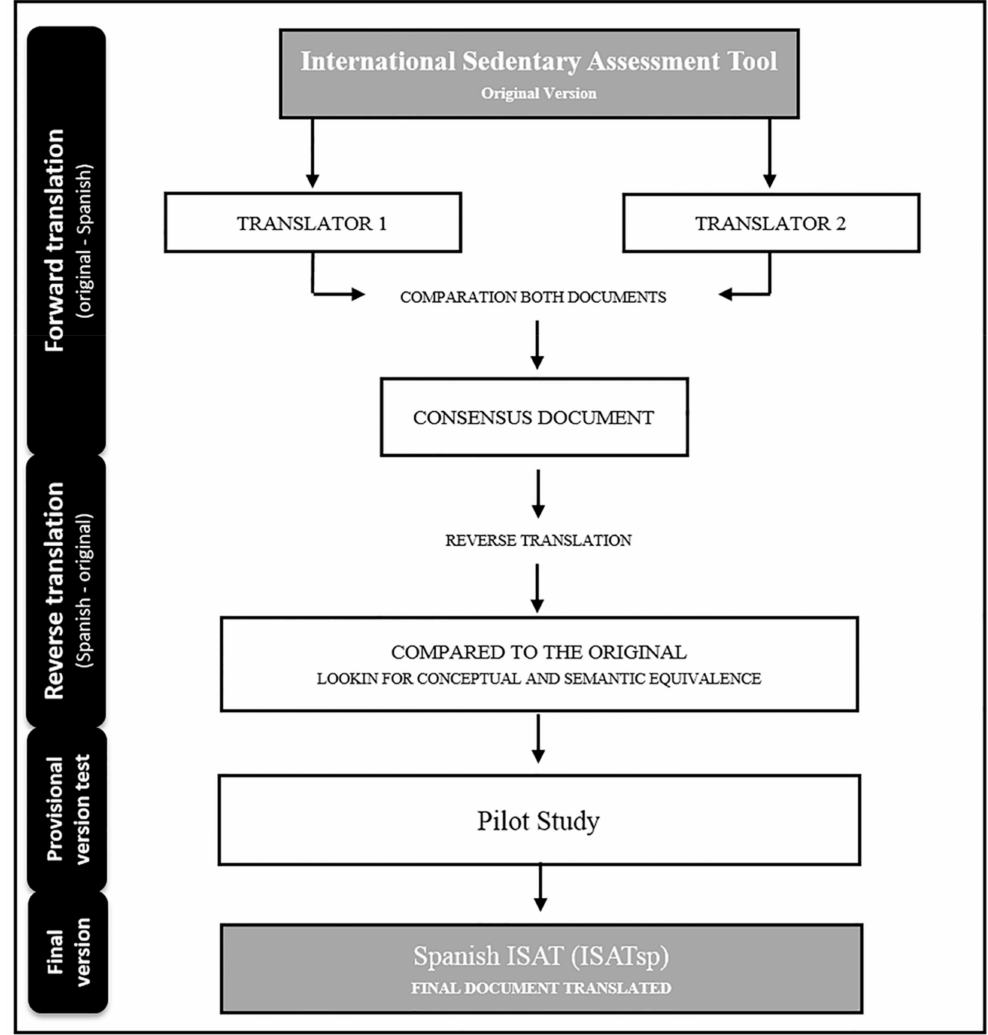
Figure 1. Flowchart of the development process ISAT Spanish version